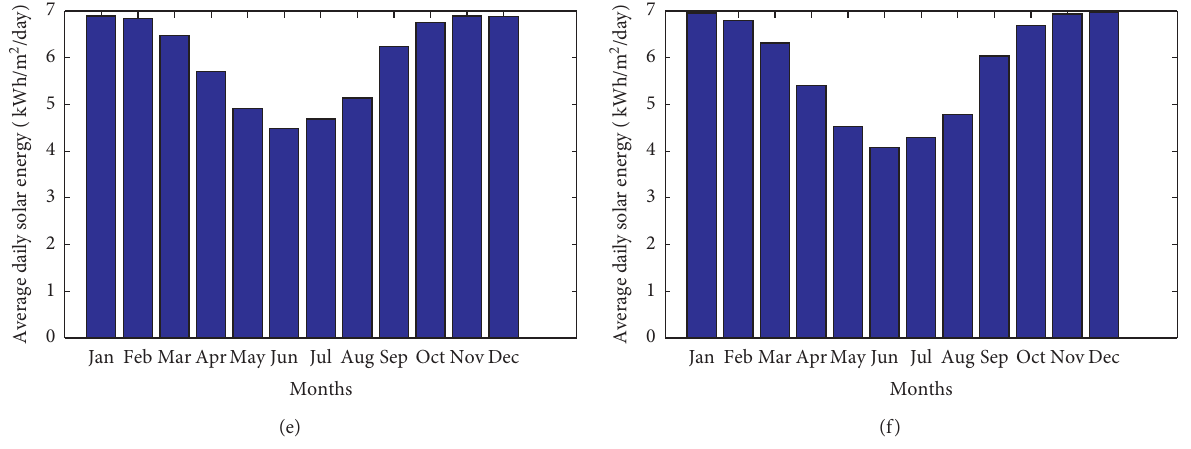
Jan ; (b) PV energy output at λ Feb ; (c) PV